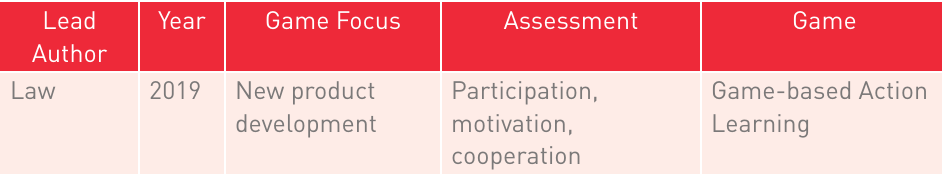
Project management simulation games